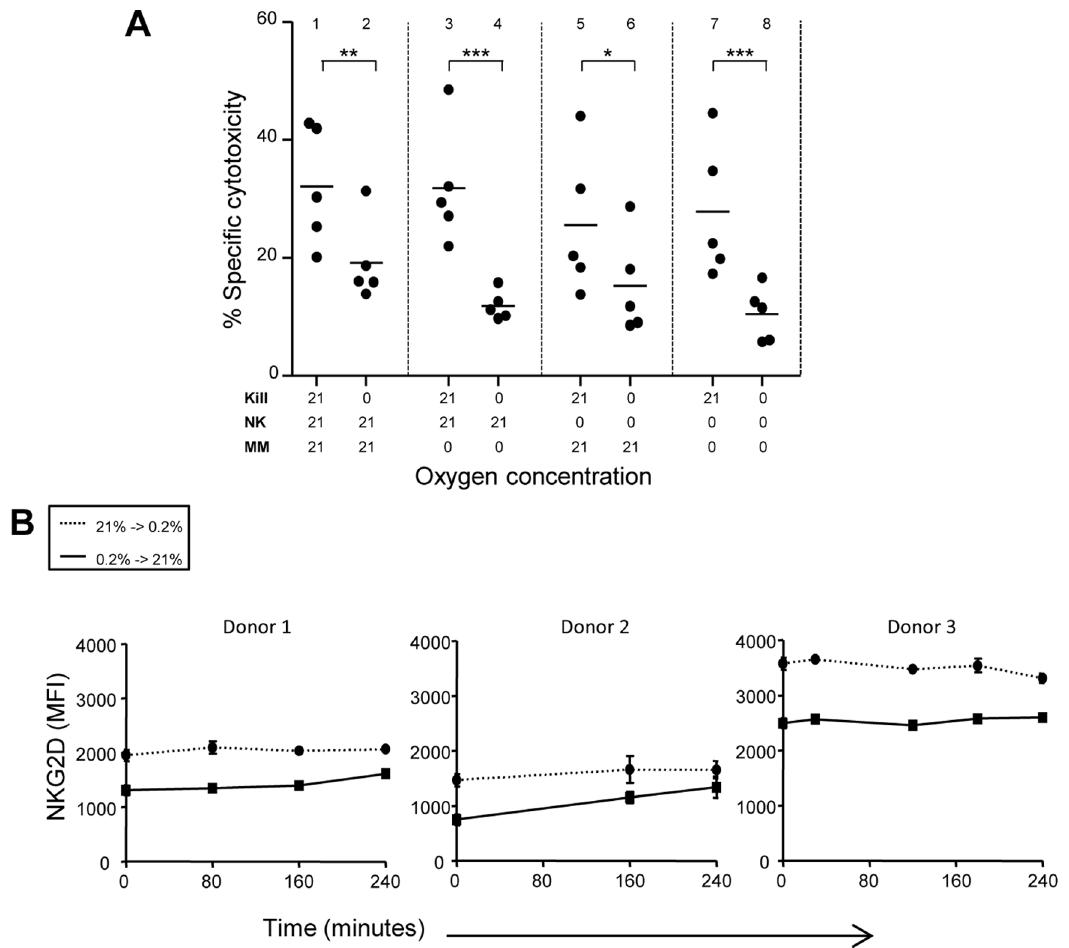
Figure 4. Oxygen concentration during NK cell killing is the key regulating parameter determining the cytotoxic potential. (A) Pre- incubation (16 hours) of MM- and NK cells followed by 4.5 hour assessment of cytotoxicity were performed at the O 2 concentration depicted on the x-axis. Each dot represents mean of triplicate cultures of individual donors. Statistics were performed with one-way repeated measures ANOVA with Bonferroni correction * p , 0.05, ** p , 0.01, *** p , 0.001. (B) To determine the kinetics of NKG2D downregulation by hypoxia, NK cells were incubated for 16 hours at 21% or 0.2% oxygen. Thereafter, cells were transferred from 21% to 0.2% or from 0.2% to 21% oxygen. After the time indicated on the x-axis, NKG2D expression was measured by flowcytometry. Data show means + SD per donor of triplicate